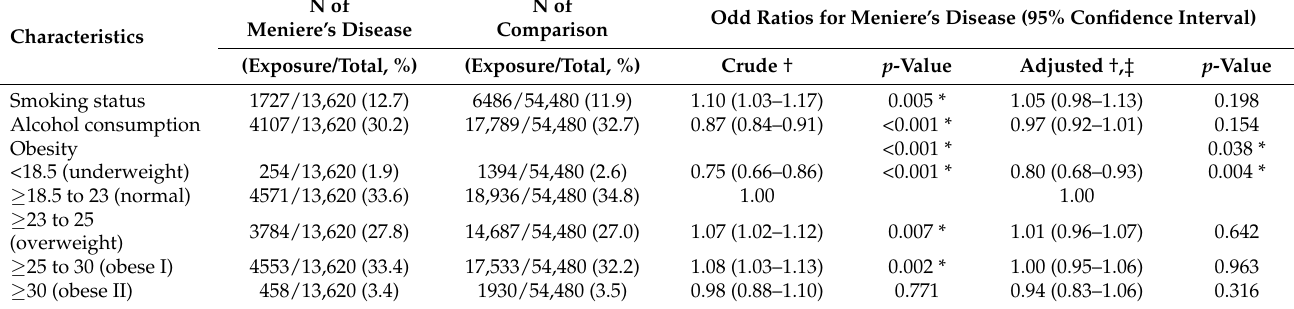
Table 2. Crude and adjusted odd ratios (95% confidence intervals) of smoking, alcohol consumption, and obesity for Meniere’s disease. * Conditional logistic regression analysis, significance at p < 0.05. † Stratified model for age, sex, income, and region of residence. ‡ Adjusted model for Charlson comorbidity index, obesity, smoking state (current smoker compared to a non-smoker or past smoker), frequency of alcohol consumption ( ≥ 1 time a week compared to <1 time a week), SBP, DBP, fasting blood glucose, total cholesterol, dyslipidemia, benign paroxysmal vertigo, vestibular neuronitis, and other peripheral vertigo.